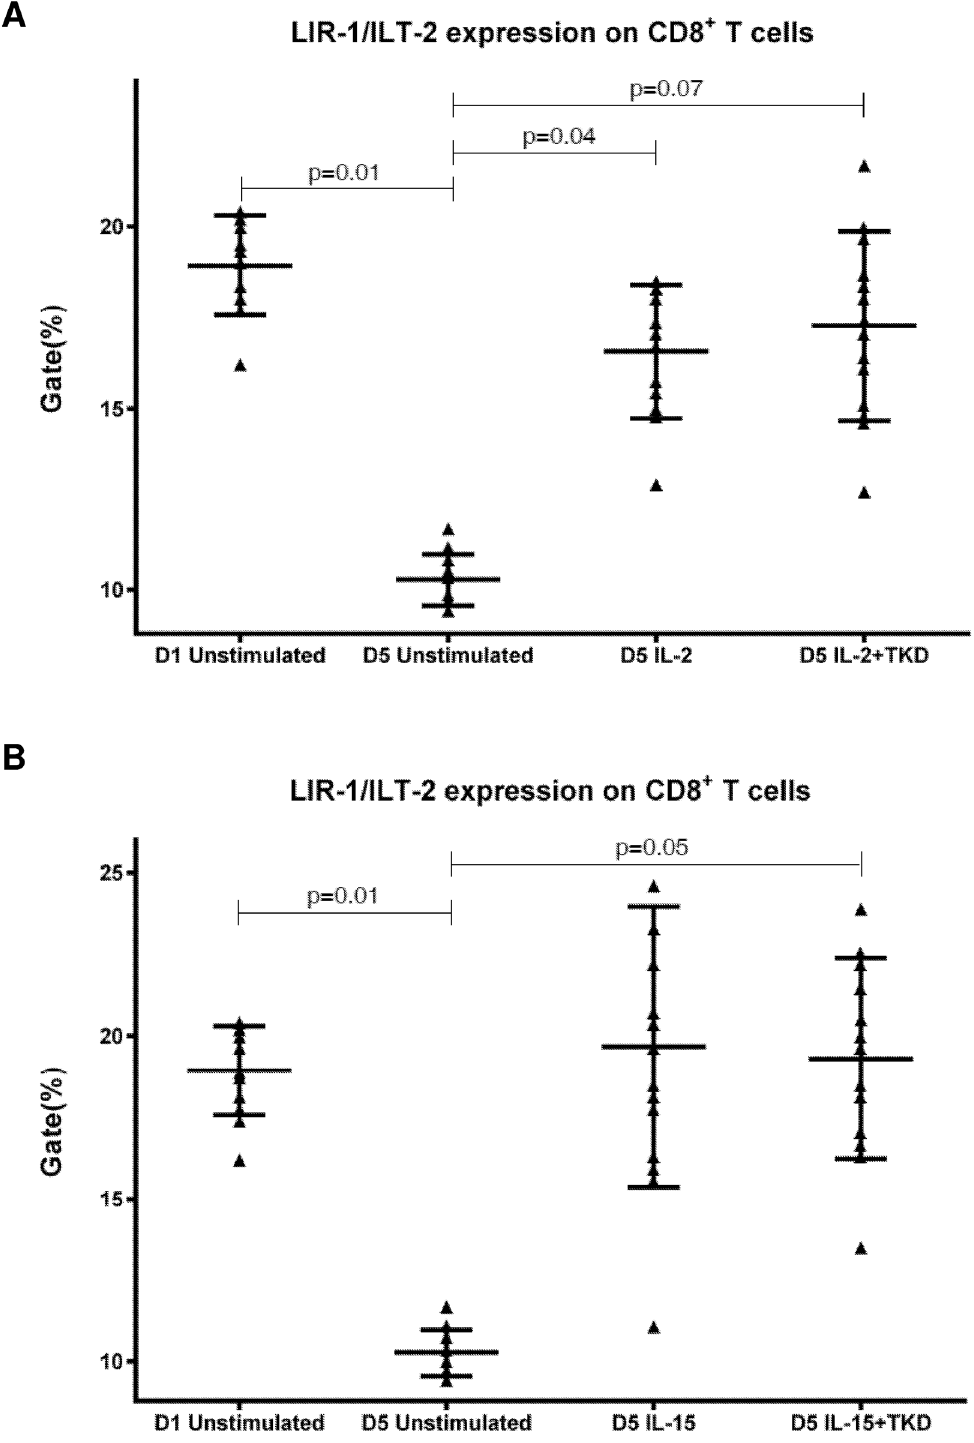
Fig 7. The effect of IL-2, IL-15, IL-2/TKD and IL-15/TKD on the expression of LIR1/ILT-2 receptor in peripheral blood mononuclear cells of healthy individuals — the proportion of CD8 + T cells expressing an appropriate receptor. The expression of LIR1/ILT-2 receptor on CD8 + T cells was examined within the fraction of unstimulated and stimulated mononuclear cells derived from 10 healthy individuals. Data are presented as means ± standard error. In total, the study cohort consisted of 52 Caucasian healthy individuals.